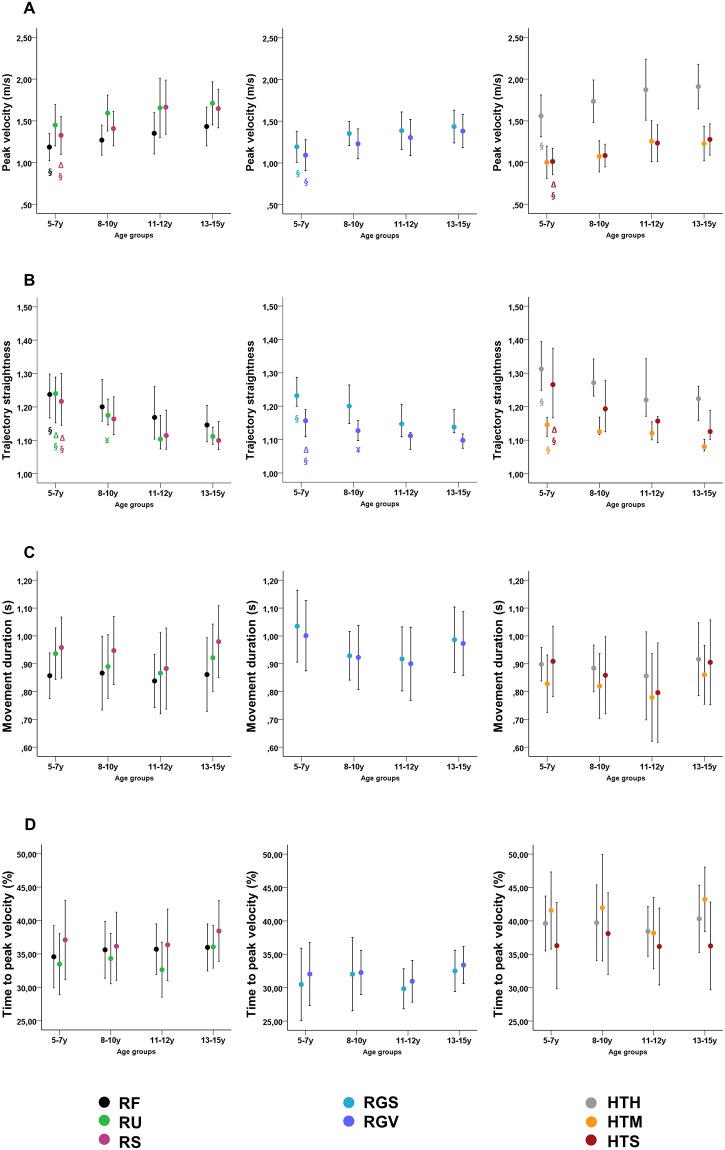
Spatiotemporal parameters per age-group for eight UL tasks (reaching, left; reach to-grasp, middle; ADL-mimicking, right): (A) peak velocity, (B) trajectory straightness, (C) movement duration, and (D) time to peak velocity.Data is shown as mean (standard deviation), except for trajectory straightness (median (first and third quartile)) RF, reaching forward; RU, reaching upwards; RS, reaching sideways; RGS, reach-to-grasp a sphere; RGV, reach-to-grasp a vertically oriented cylinder; HTH, hand-to-head; HTM, hand-to-mouth; HTS, hand-to-shoulder; y, years. Significant post-hoc differences (Bonferroni-Šidák correction α<0.0085) are shown as follows: Δ between 5-7y and 11-12y, § between 5-7y and 13-15y, and ¥ between 8-10y and 13-15y. Post-hoc analyses did not show significant differences for other between-group comparisons.